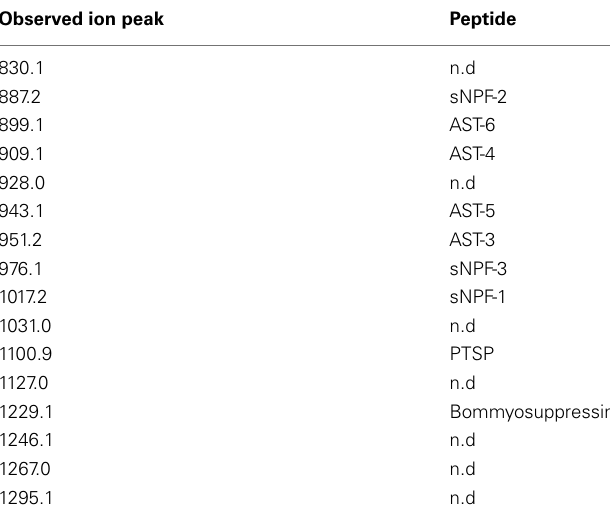
Table 1 | Ion peaks detected by direct MALDI-TOF MS analyses of fifth instar B. mori larvae brain.